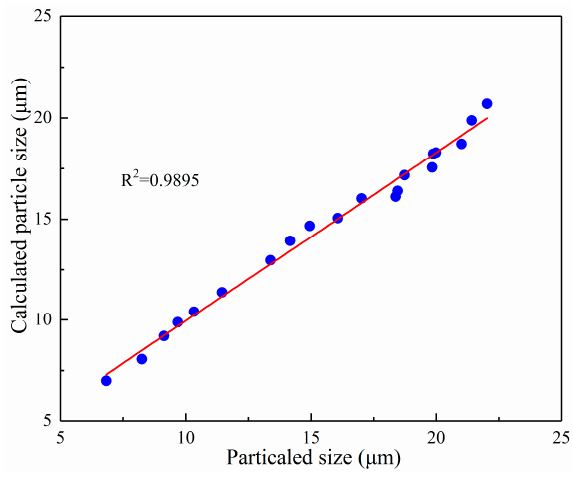
Figure 14. Comparison of calculated and experimental data of iron grain granularity.